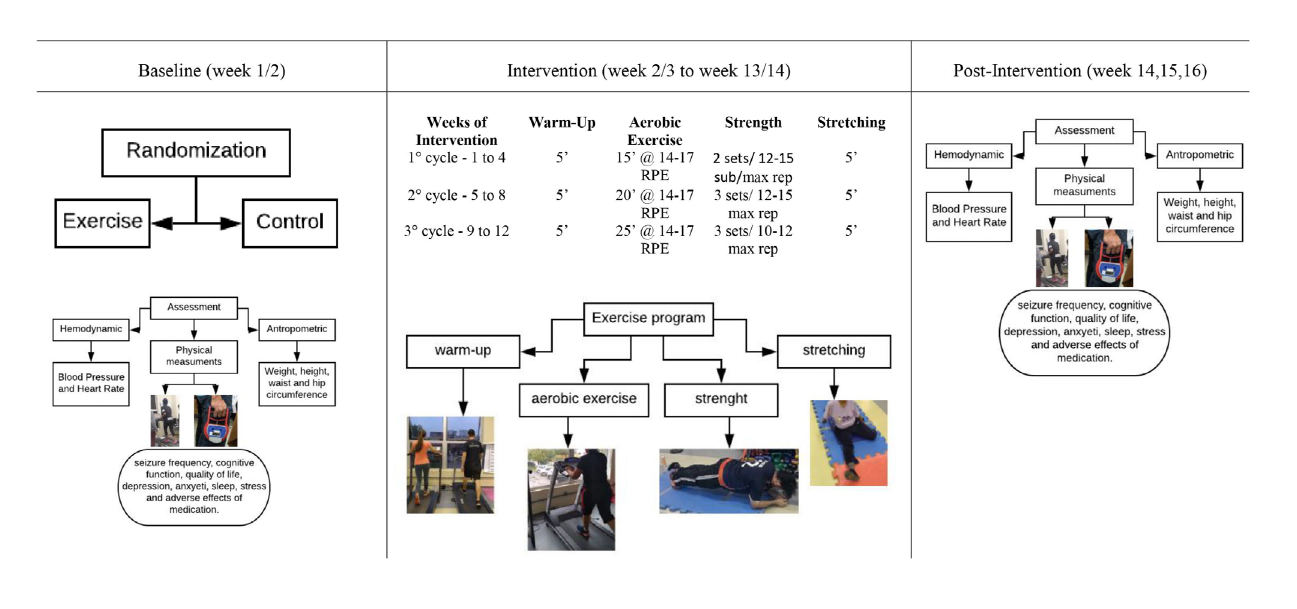
Figure 1 - Overview of the protocol. Max rep: maximal repetition; Sub: submaximal repetition; RPE: rating of perceived